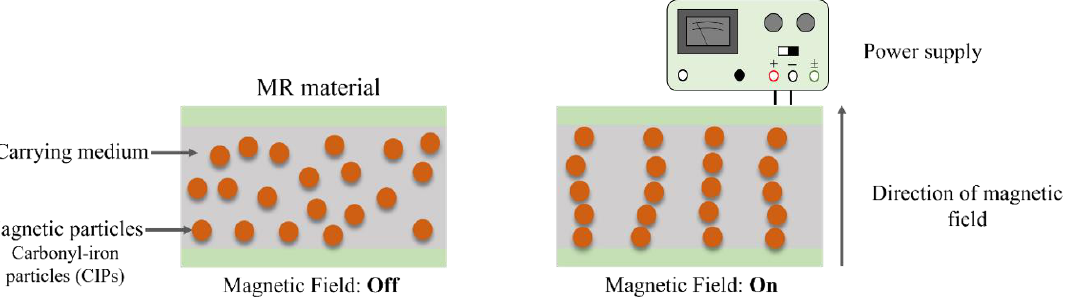
Figure 1. The distribution of the magnetic particles in MREs with and without magnetic field.